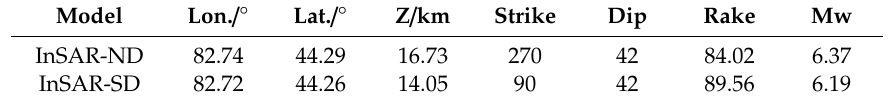
Table 3. Determined source parameters for the north dipping and south dipping models 1 .